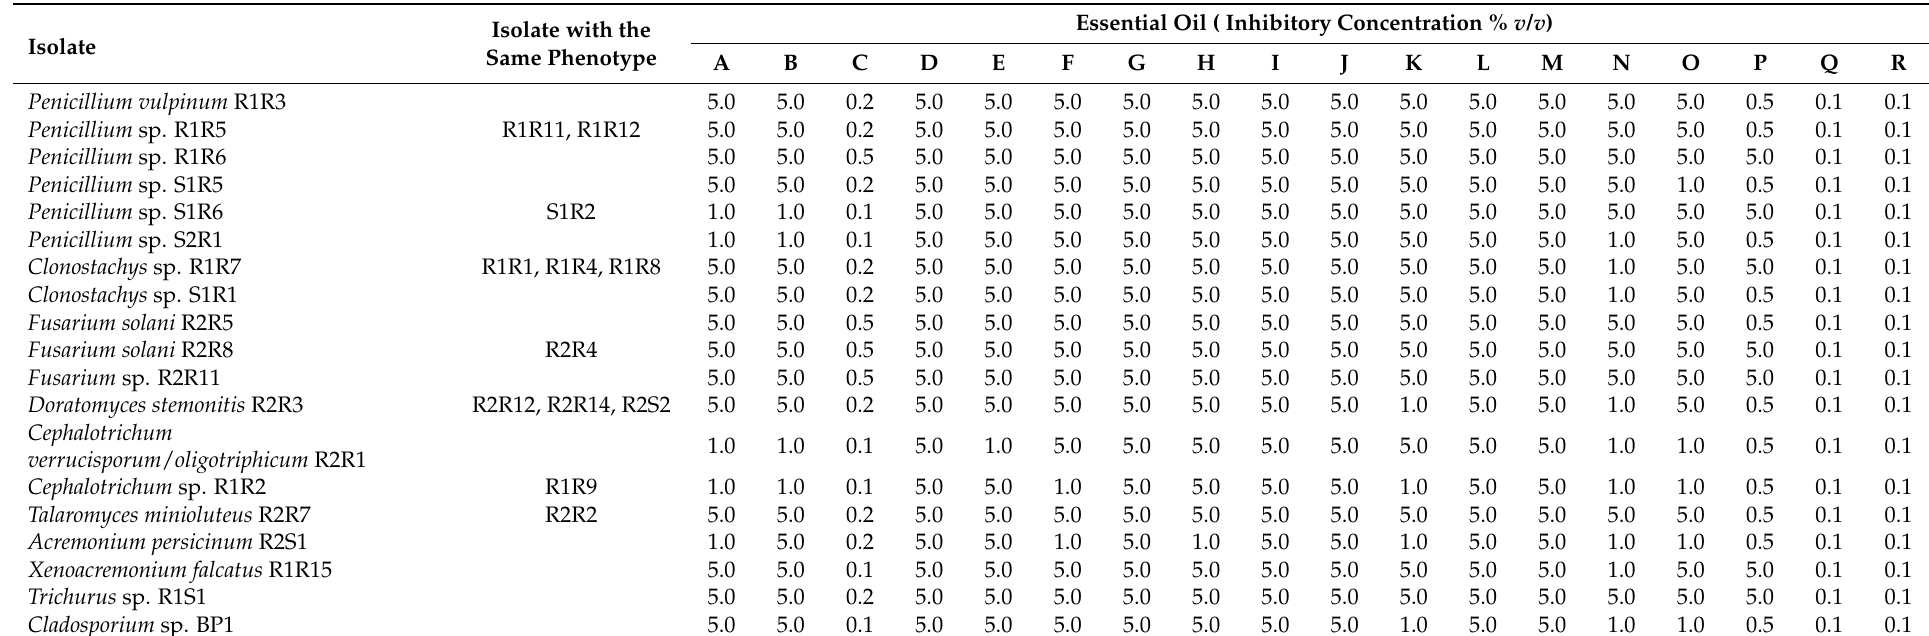
Table 3. Antimicrobial activity of the 18 EOs on the fungal